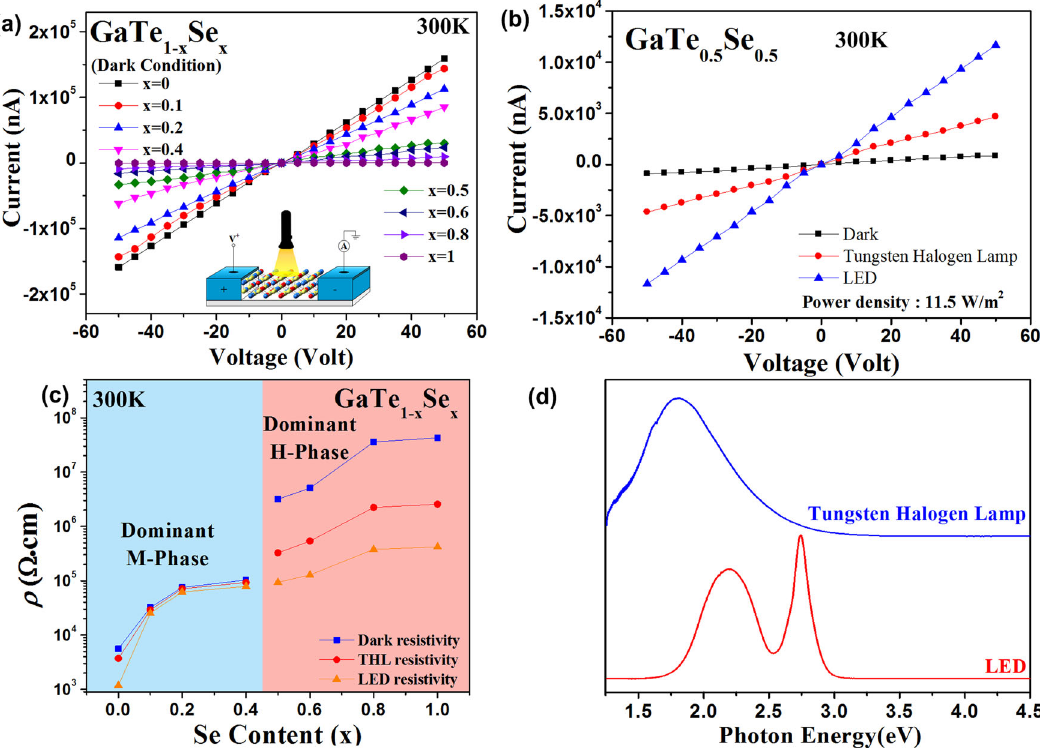
Fig. 6 Photoconductivity properties of layered GaTe 1 − x Se x . a V – I characteristics of the layered GaTe 1 − x Se x (0 ≤ x ≤ 1) under dark conditions. The inset image is an illustration of the two-point Photo V – I measurement set-up. b Photo-resistivity result of a representative sample of GaTe0 .5 Se 0.5 under dark conditions, illumination by white-light LED, and illumination by a THL. c Photo-resistivity versus Se content in full- series GaTe 1 − x Se x (0 ≤ x ≤ 1) under dark conditions, illumination by white-light LED, and illumination by THL. The power density of the light sources was controlled at 11.5 W m − 2 . ( d ) Illumination spectra of the THL and LED at the power density of 11.5 W m − 2